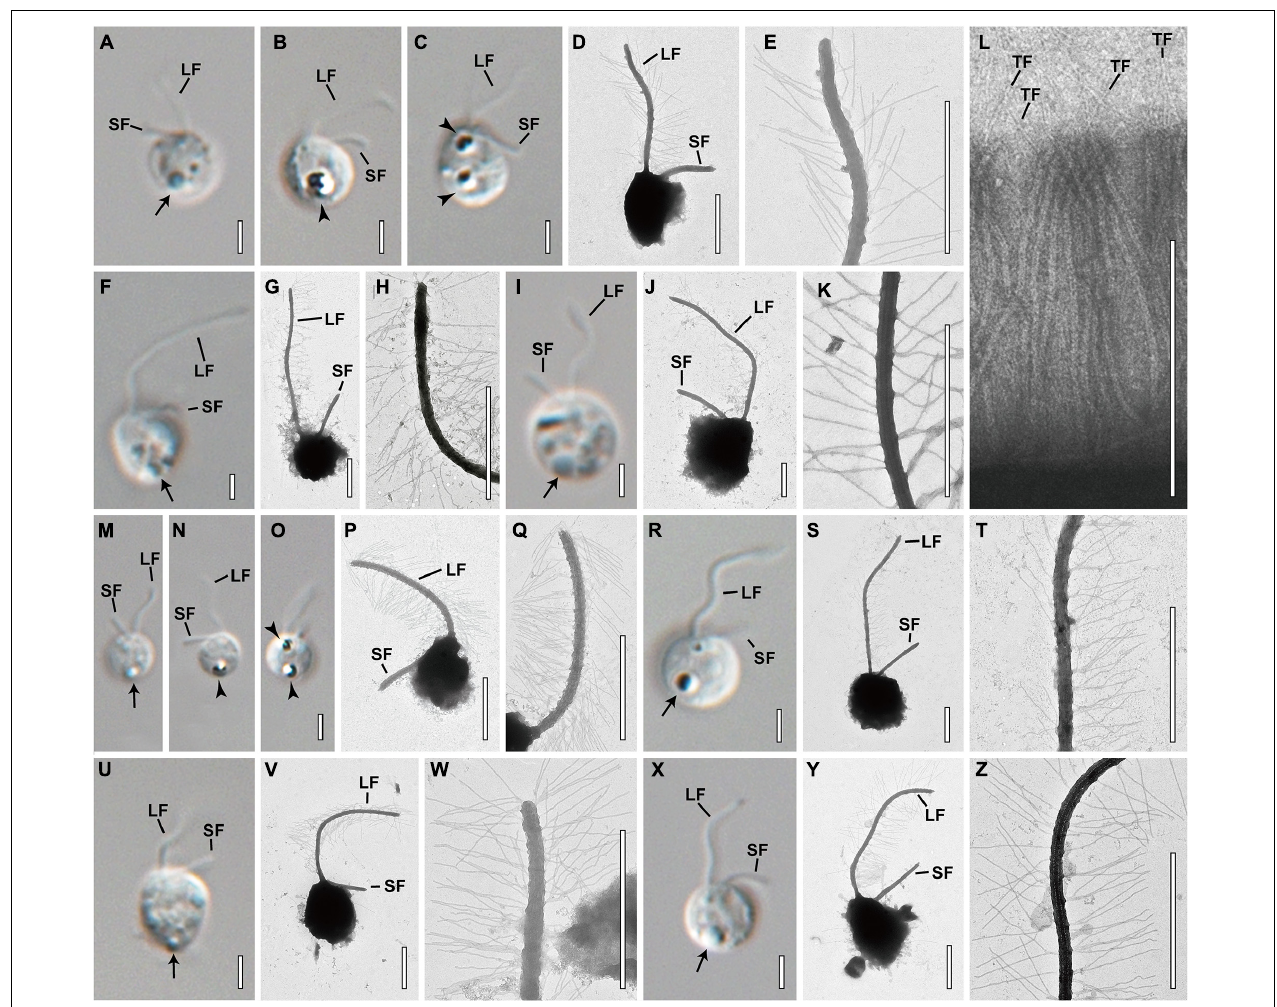
FIGURE 4 | Light and transmission electron micrographs of Spumella species. Images showing each species having a long flagellum (LF) with two rows of mastigonemes, a terminal filament (TF) in the mastigonemes and a short flagellum (SF). Leucosin vesicle (arrow) and leucosin vesicles containing brilliant crystals (arrowhead) located on the anterior and posterior sides of the cell. (A–E) Image of S. benthica Hwarim032418A5. (F–L) Images of S. communis Meonmulgak032418A6. (I–L) Images of S. longicolla Yangrim041319B6. (M–Q) Images of S. oblata Sanggul120318B3. (R–T) Images of S . rotundata Woeam020118A5. (U–W) Images of S . similis Gwanje012018A2. (X–Z) Images of S . sinechrysos Hwarim032418A7. Scale bars = 2 µ